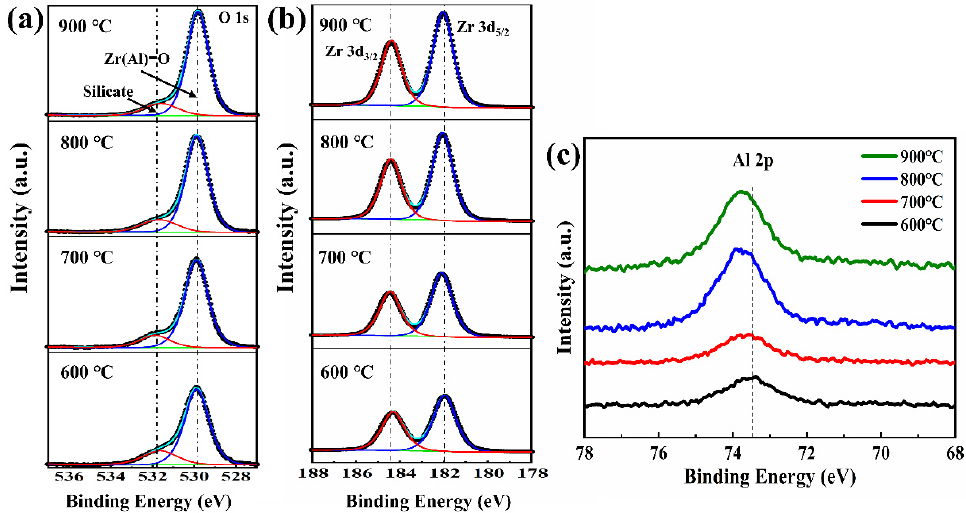
Figure 4. ( a ) O 1s XPS spectra of AZO films. ( b , c ) Zr 3d spectra and Al 2p spectra in the films.